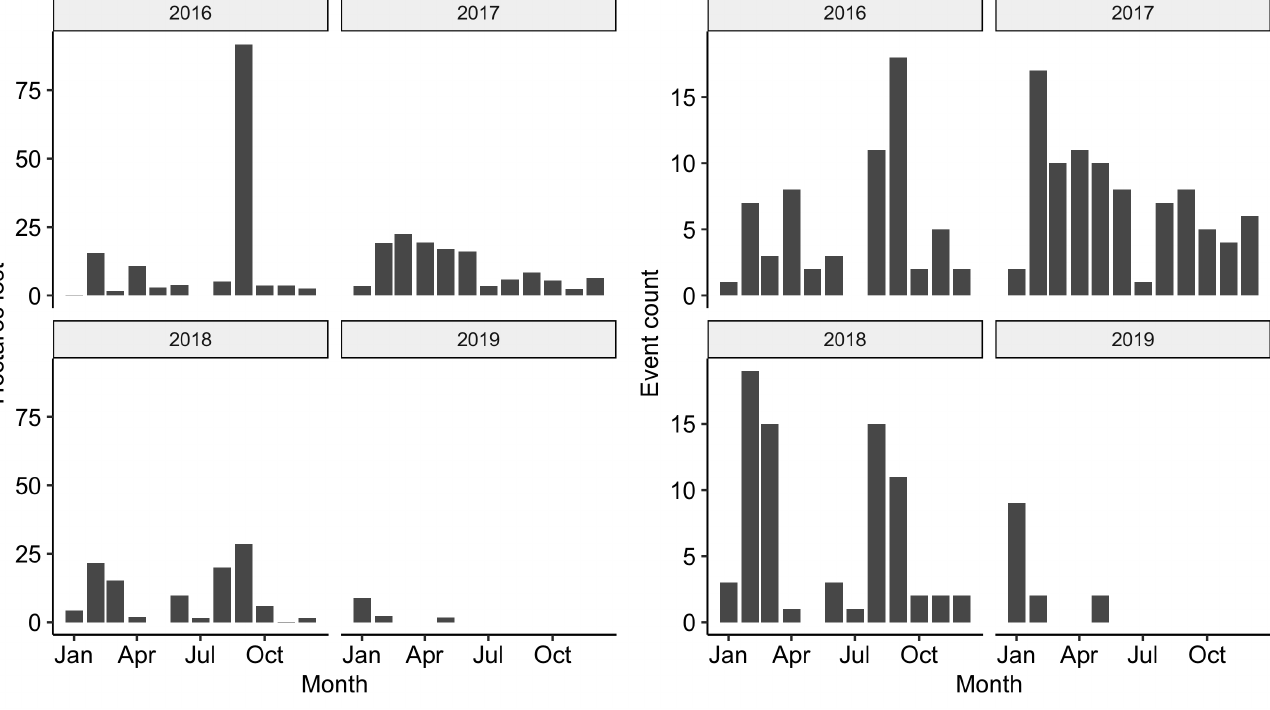
Figure 6. Hectares of Renosterveld lost ( left ) and number of loss events ( right ), defined as spatially contiguous polygons, by month and year over the study